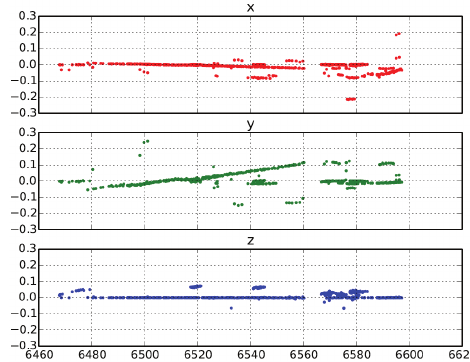
Figure 8. Residual vectors along the trajectory from linear position 6470 m to position 6600 m before adjustment, for scanner 1. Components of the residual vector are split into x , y and z plots.